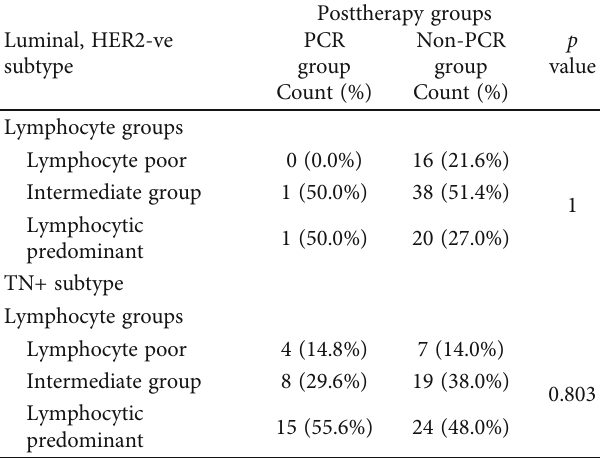
Table 3: Association count (%) between TIL and PCR in the 2 molecular subtypes among 153 breast cancer cases (chi-square